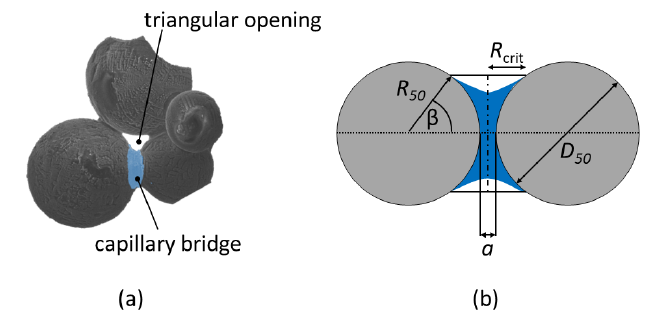
Figure 3. ( a ) Section of an SEM image of the formation of a capillary bridge highlighted in blue and a triangular pore between the Al 2 O 3 powder particles in a binder jetted green part; ( b ) geometrical determination of R crit in a capillary